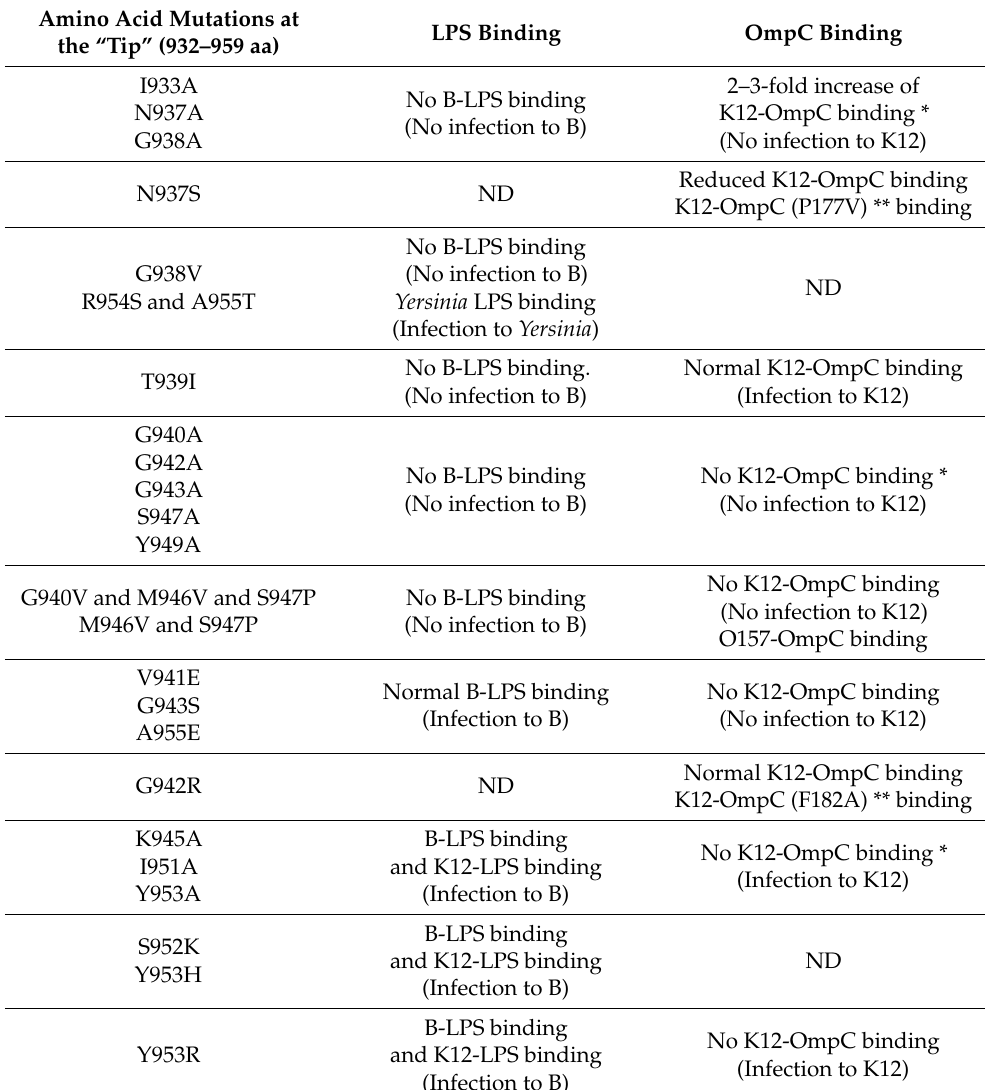
Table 1. The key amino acid residues in the T4 LTF “tip” subdomain involved in the interaction with LPS and OmpC receptors. (*) the binding between OmpC and LTF was determined by in vitro enzyme-linked immunosorbent assay (ELISA) using purified OmpC protein and the LTF needle (gp37; amino acids 799–1026) [58]. (**) the wild-type T4 phage is unable to infect the E. coli K12 strain with P177V or F182A mutation in the K12-OmpC receptor. ND, not determined. Amino Acid Mutations at LPS Binding OmpC Binding the “Tip” (932–959 aa) 2–3-fold increase of I933A No B-LPS binding N937A (No infection to B) G938A